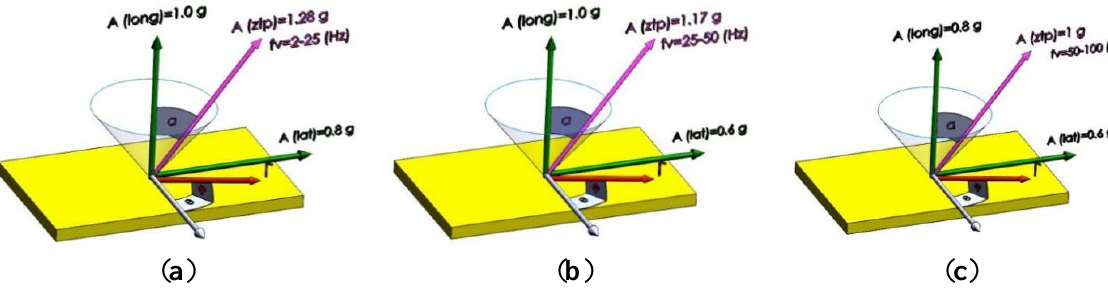
Figure 14. Sinusoidal vibrations of the Ariane 5 launch vehicle. Adapted from [7].